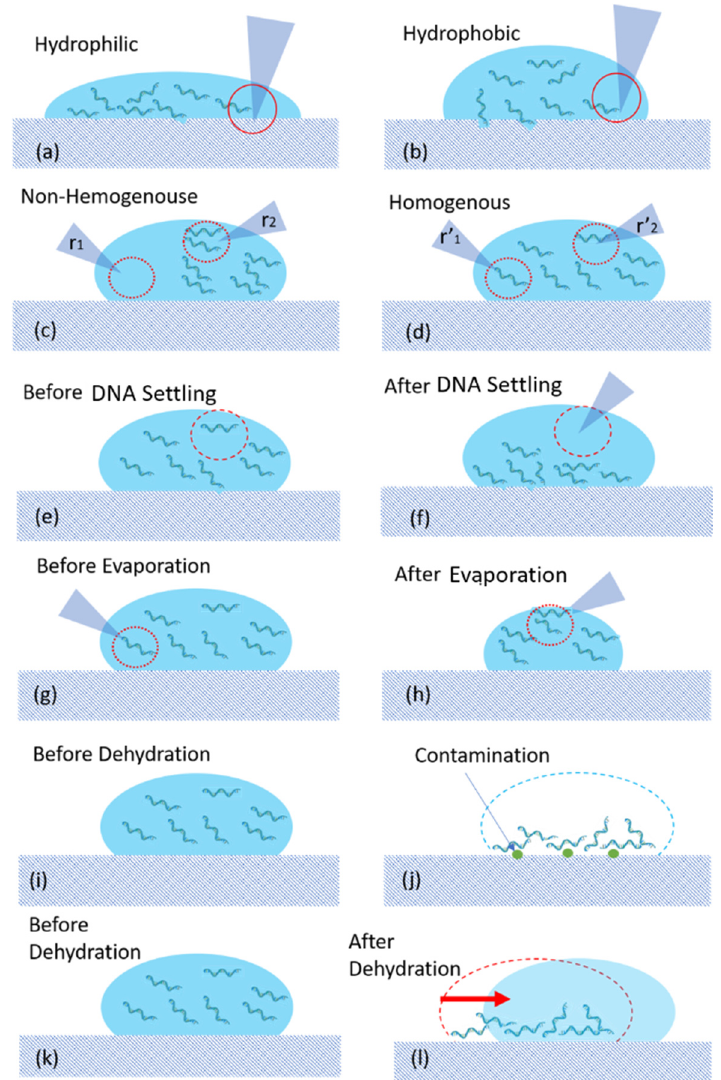
Figure 10. The source of non-idealities in the DNA sample deposition and sample retrieval, ( a , b ) Hydrophilicity effect; ( c , d ) Non-homogeneity; ( e , f ) Deposition of DNA to surface; ( g , h ) Evaporation; ( i , j ) Contamination; ( k , l ) Misalignment.